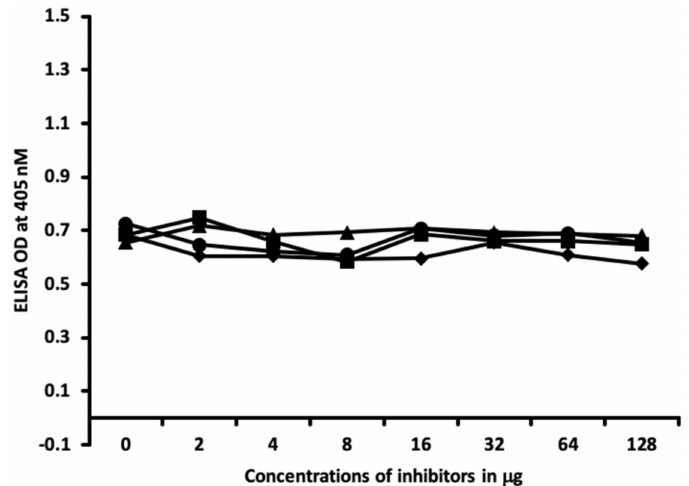
Figure 11. Binding of thyroid peroxidase antibody to formaldehyde-HSA in the absence or presence of formaldehyde-HSA, isocyanate-HSA, BPA-HSA, and mercury-HSA in concentrations of 0, 2, 4, 8, 16, 32, 64, and 128 µ g / mL. (cid:7) = Formaldehyde-HSA; (cid:4) = isocyanate-HSA; (cid:78) = BPA-HSA; • =